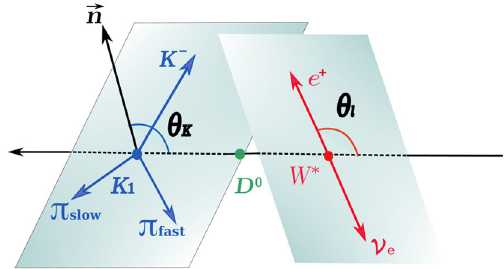
( K − π + π − ) e + ν Fig. 1 The kinematics for D 0 → K − e . The relative 1 angle between the normal direction of K − decay plane and the opposite 1 of the D 0 flight direction in the K − rest frame is denoted as θ K , where 1 the normal direction of K − decay plane is defined as p π, slow × p π, fast 1 in which p π, slow and p π, fast corresponding to the momenta of the lower and higher momentum pions, respectively. The θ l is introduced as the relative angle between the flight direction of e + in the e + ν e rest frame and e + ν e in the D 0 rest frame [16]